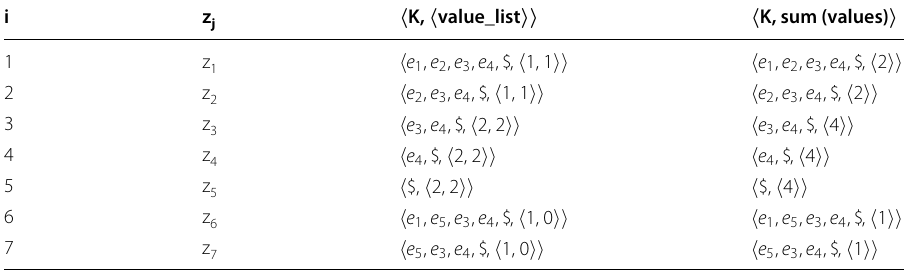
Table 7 Computation of sum of value_list associated with keys by reducer function